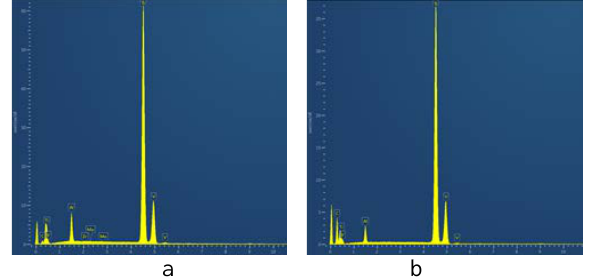
Fig.5. Spectral analysis results of the initial wire (a) and the atomized powder (b) of the Ti-6Al-4V